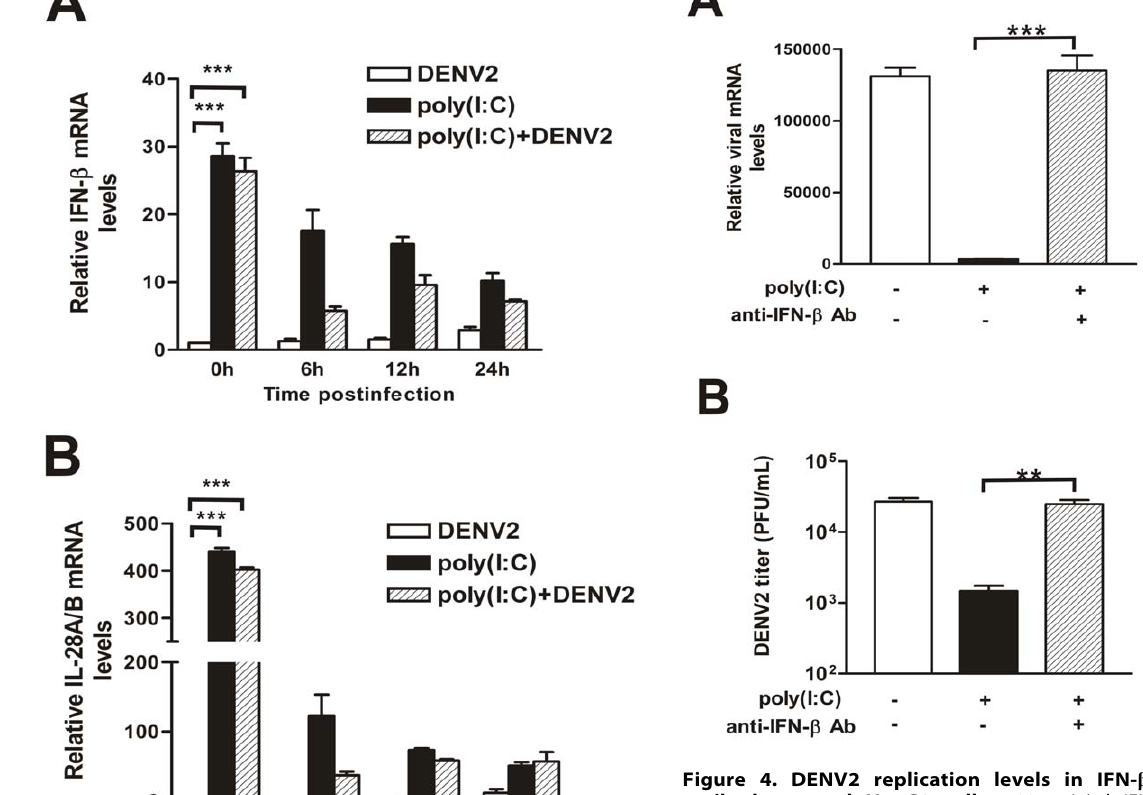
Figure 4. DENV2 replication levels in IFN- b neutralizing antibody treated HepG2 cells. 500 unit/ml IFN- b neutralizing antibody was added at 1 h before poly(I:C) treatment and kept through poly(I:C) treatment and virus infection. (A) Real-time PCR detecting the expression of viral mRNA; (B) Extracellular viral production determined by TCID50. Supernatants were harvested at 24 h p.i. and titered on C6/ 36 cells. Error bars represent the standard error of mean from the average of three experiments. Student’s t test, **, p , 0.01; ***, p ,